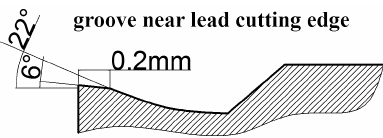
Figure 3. Geometry of the chip groove: TiAlN-coated insert.